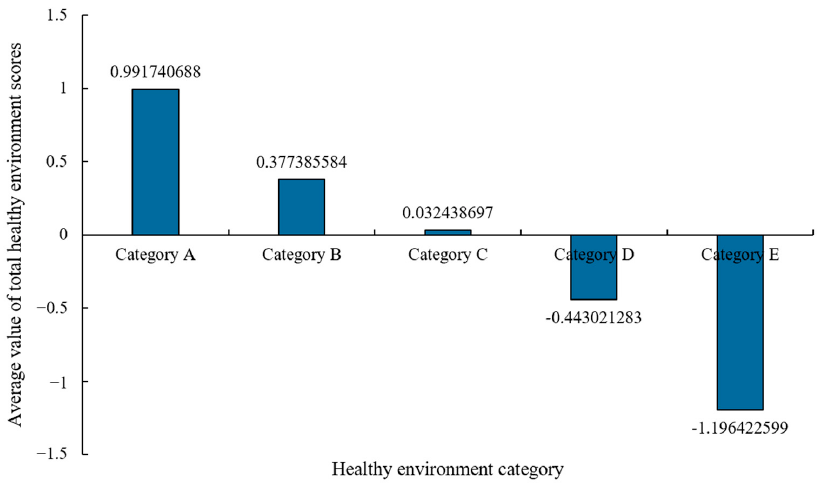
Figure 3. Average score of five healthy environment categories.